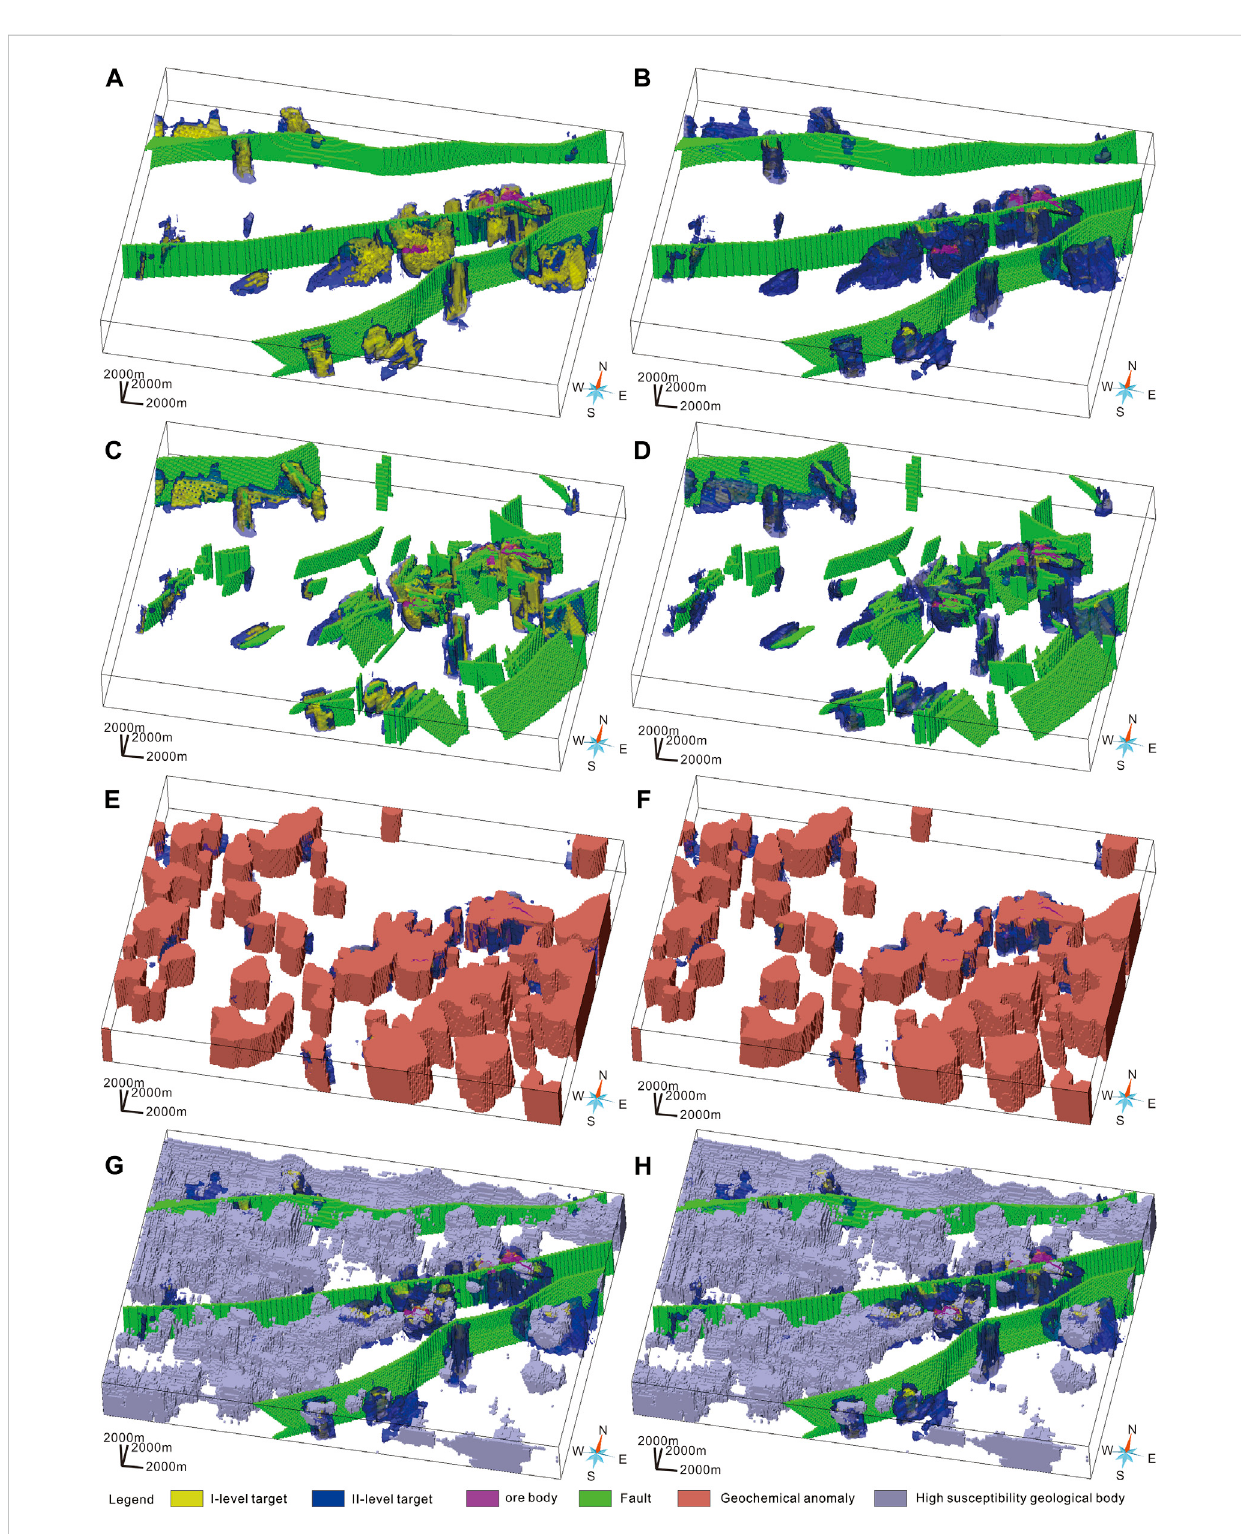
FIGURE 14 The Ⅰ -leveltargetsand Ⅱ -leveltargetsofRF28andXGBoost11superimposeexplorationcriteria: (A) and (B) regionalfault; (C) and (D) secondaryfault; (E) and (F) geochemical anomaly; (G) and (H) high magnetic susceptibility geological